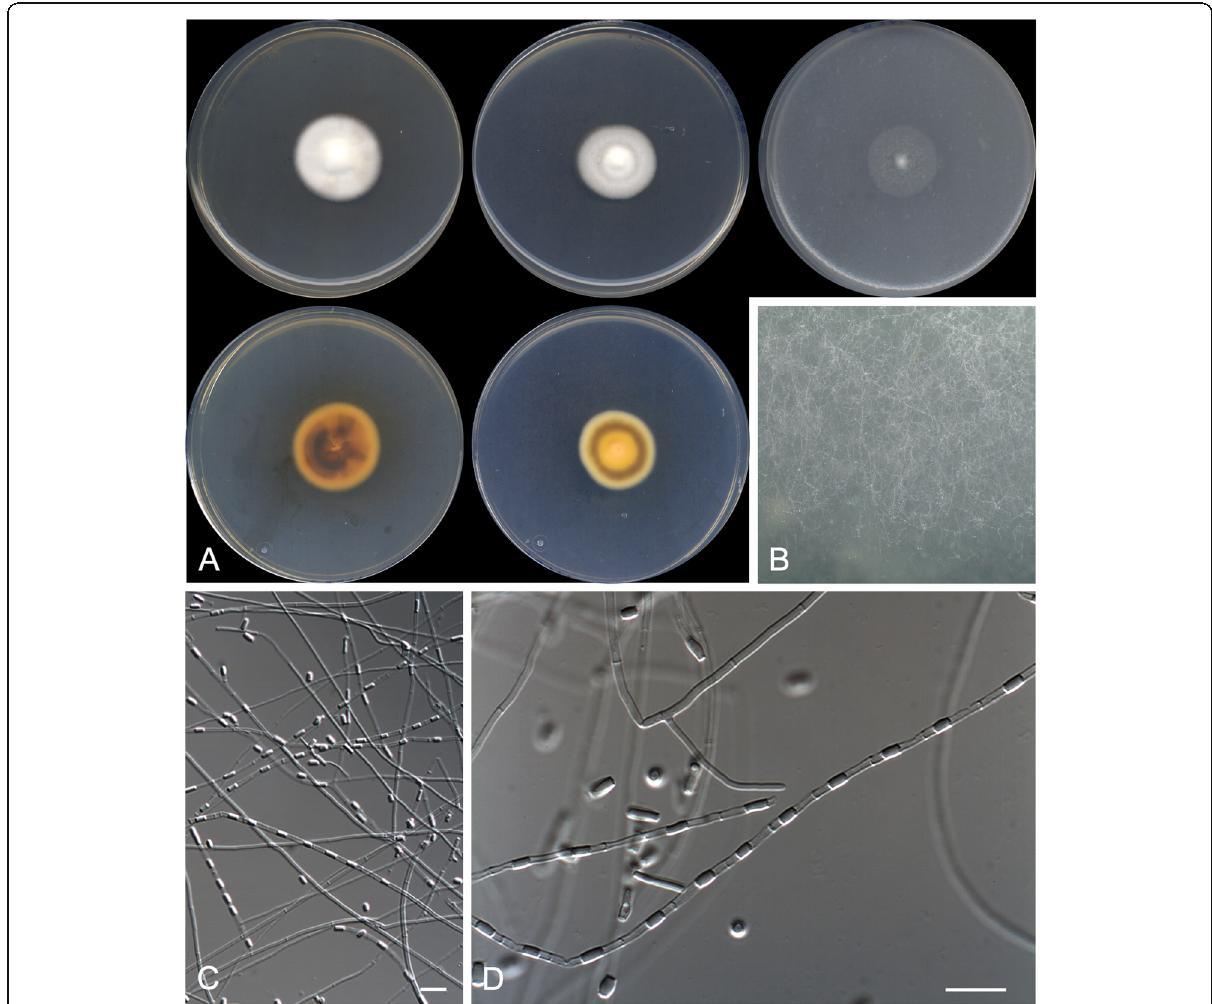
Fig. 5 Currahmyces sparsispora CBS 146929 T . a Colonies on PYE, PDA and OA after 14 d at 25 °C, from left to right (top row, surface; bottom row, reverse). b Detail of the colony on OA. c – d Intercalary arthroconidia along the fertile hyphae. Scale bar = 10 μ